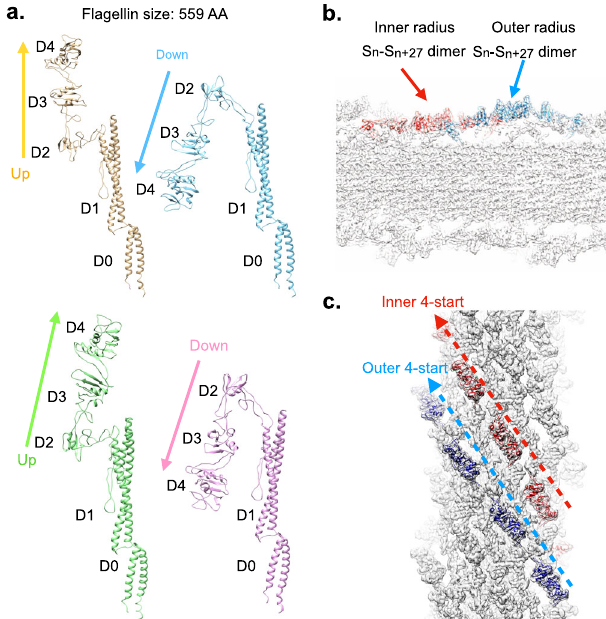
Fig. 4 Structural details of the tetrameric Achromobacter fl agellar fi lament. a The four fl agellin conformations within the Achromobacter fl agellar fi lament asymmetric unit. b Achromobacter outer domain interactions from subunits S n :S n + 27 occur at two different radii. c The two different dimer conformations result in two left-handed 4-start helices on the surface of the Achromobacter fl agellar fi